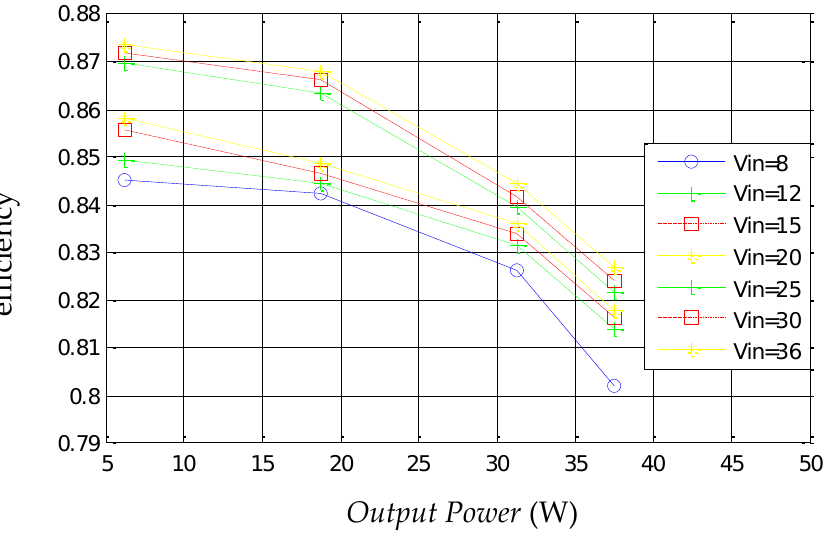
Figure 14. Measured efficiency with input voltage ranging from 8 to 36 V under different LED loads.